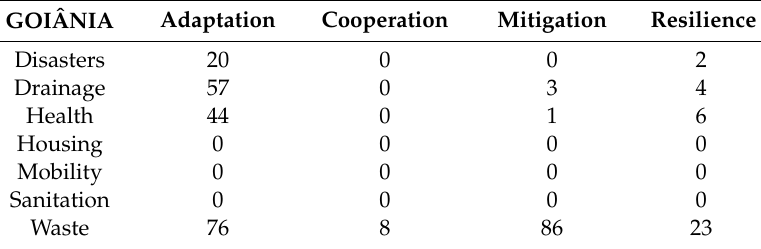
Figure 10. Climate action references in Curitiba’s sectoral plans. Table 10. Climate action references in Goiânia’s sectoral plans.